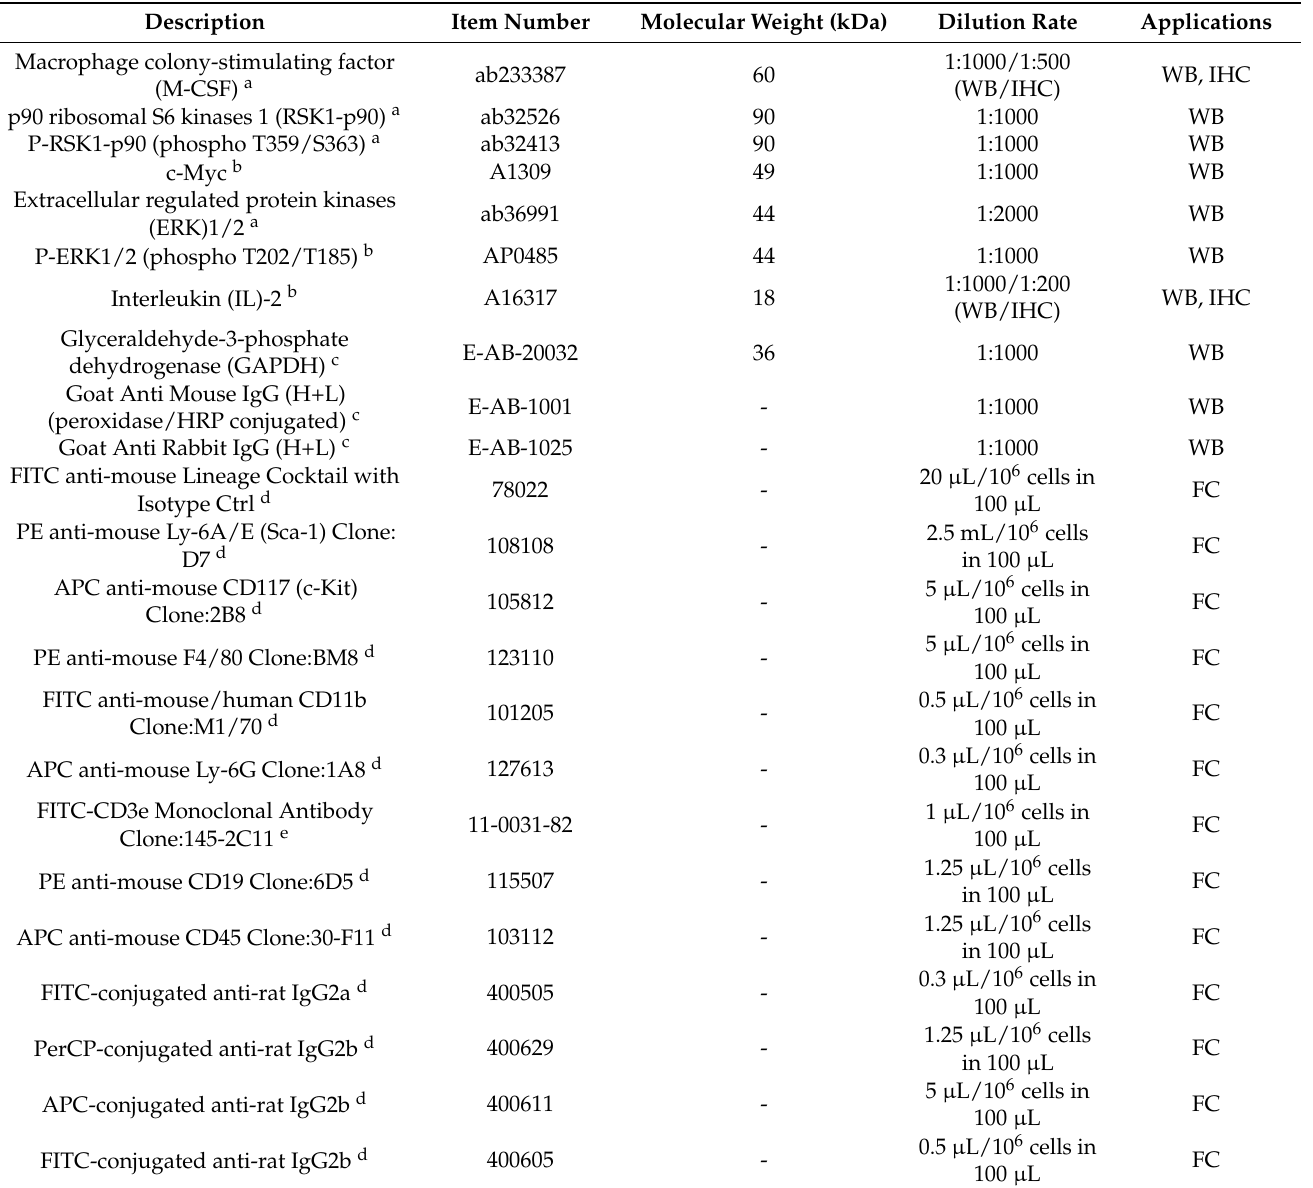
Table 1. Antibody